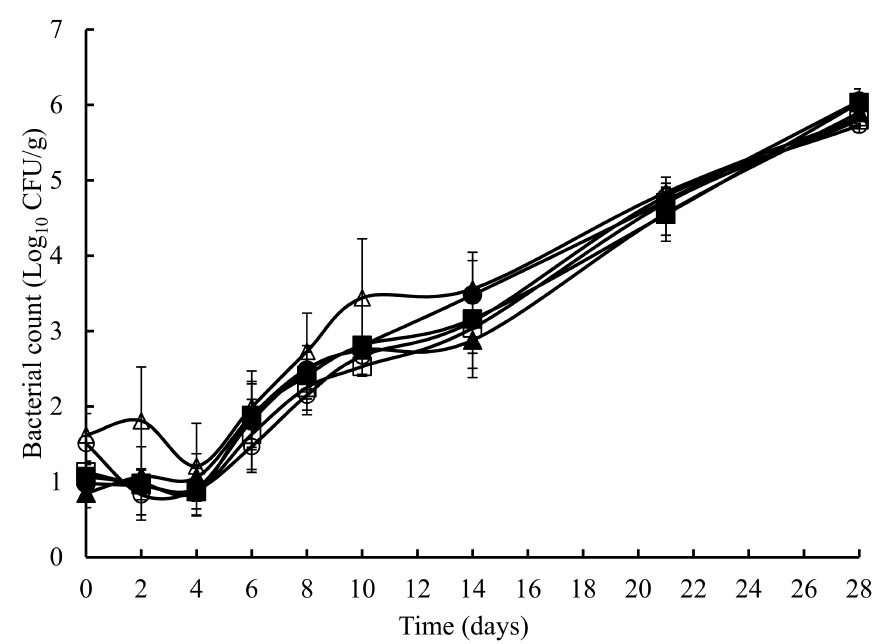
Figure 5. Clostridium spp. in crab meat samples stored at 4 ◦ C with the following treatments: SDW ( (cid:4) ), Ascorbic Acid ( ), Casein ( (cid:78) ), Casein and Ascorbic Acid ( (cid:3) ), Potato Starch (o), and Potato Starch and Ascorbic Acid ( ∆ ). The error bars represent 1 standard deviation.